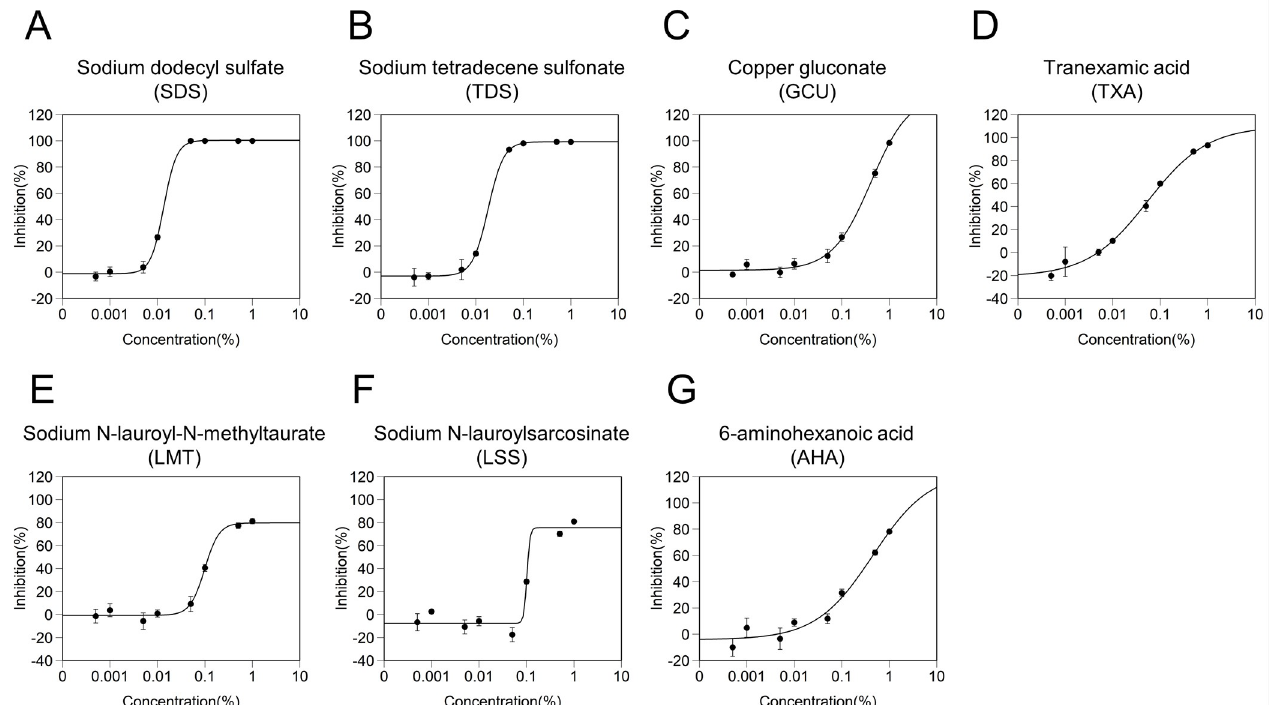
Fig 4. Effect of ingredient concentration on inhibitory effects of serine protease activity of TMPRSS2. The dose-response inhibitory effects of TMPRSS2 serine protease activity by (A) Sodium dodecyl sulfate, (B) Sodium tetradecene sulfonate, (C) Copper gluconate, (D) Tranexamic acid, (E) Sodium N-lauroyl- N-methyltaurate, (F) Sodium N-lauroylsarcosinate, and (G) 6-aminohexanoic acid are shown. The data were plotted and modeled by a four-parameter Log- logistic fit to determine the 50% inhibitory concentration (IC50) value. All data points expressed as the mean ± SD (n = 3).